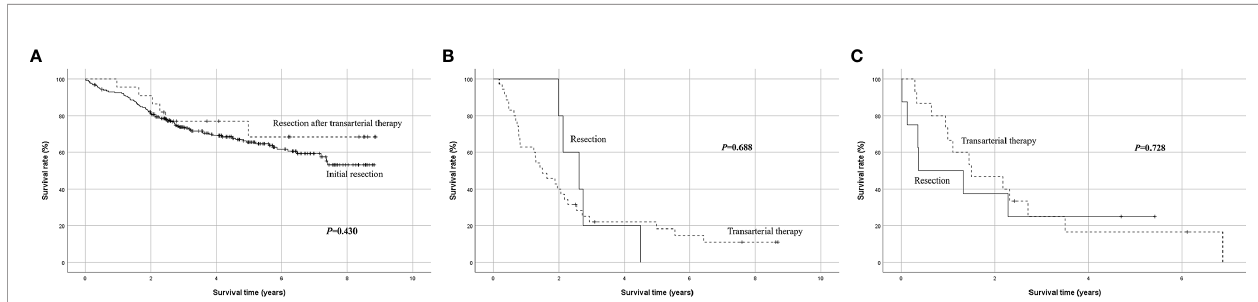
FIGURE 4 | Subgroup Kaplan-Meier analysis of overall survival. (A) Initial resection vs. resection after transarterial therapy, (B) resection vs. transarterial therapy in patients with low platelet count < 100 × 10 9 /L, (C) resection vs. transarterial therapy in patients with low serum sodium < 135